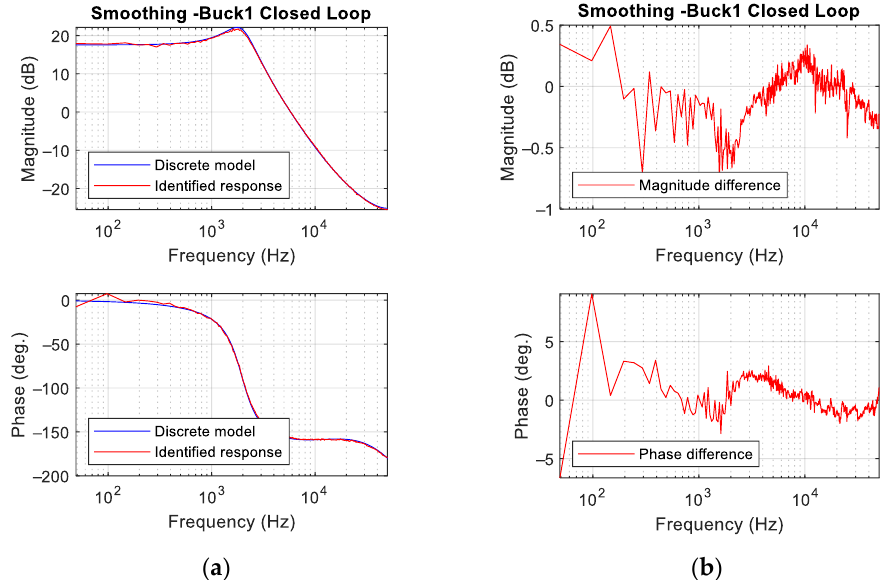
Figure 13. Results for Buck1 converter working closed loop. ( a ) Bode plot with smoothing process. ( b ) Difference between theoretical discrete model and experimental measurements with smoothing process.